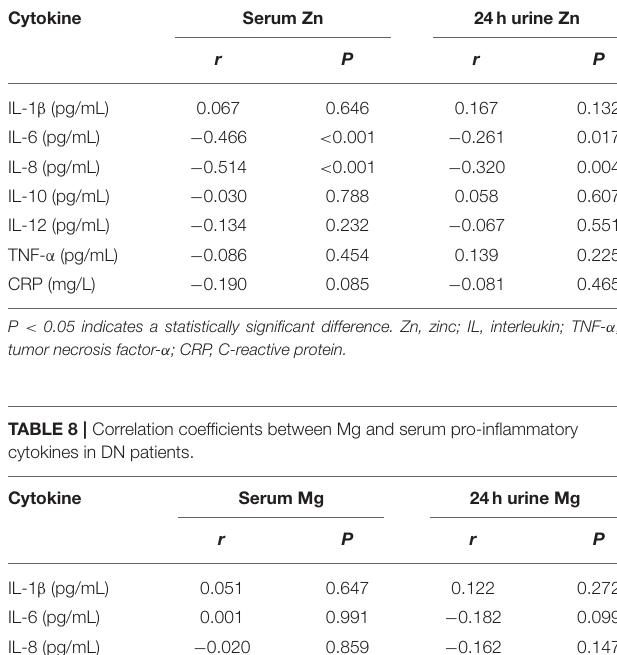
TABLE 7 | Correlation coefficients between Zn and serum pro-inflammatory cytokines in DN patients. Cytokine Serum Zn